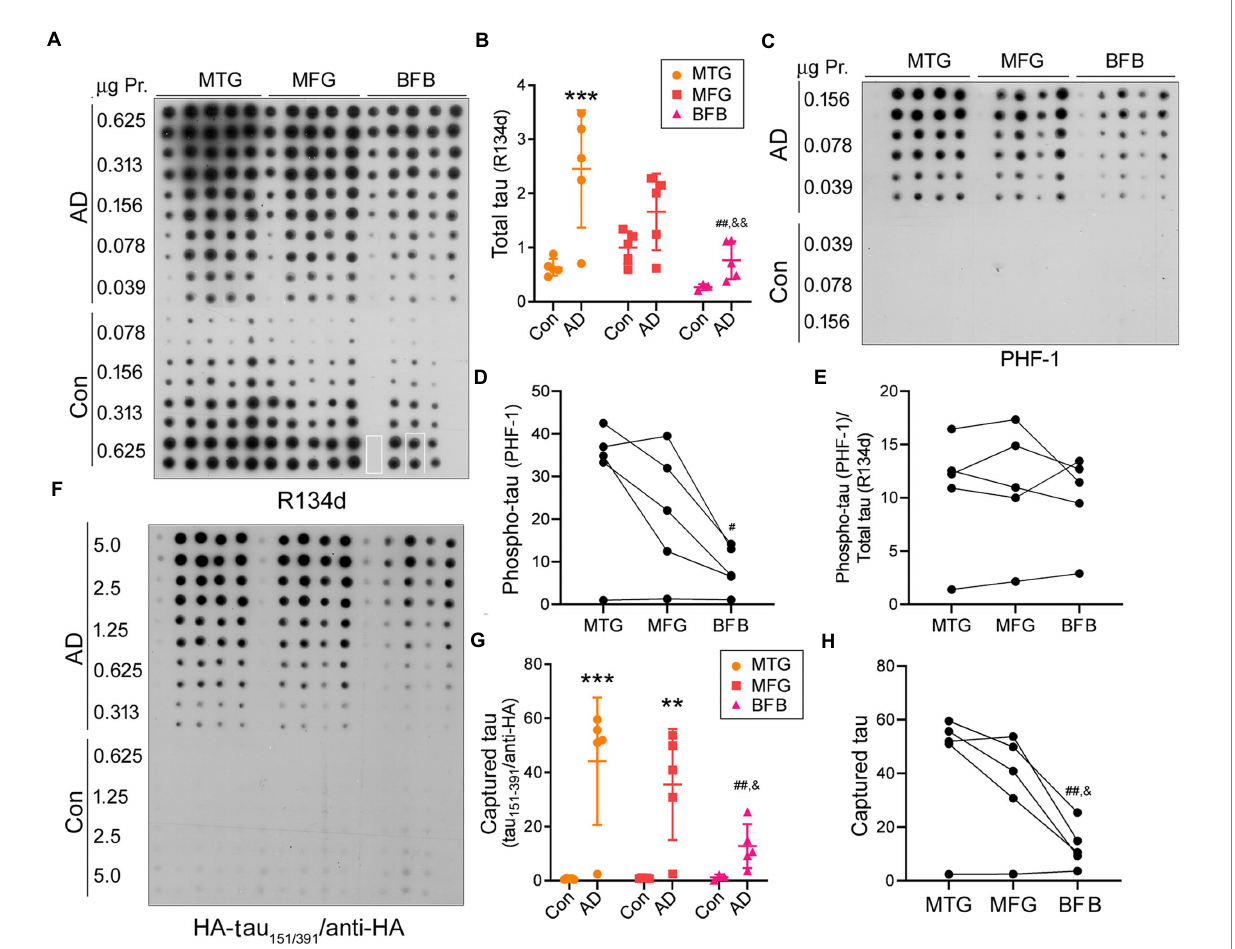
FIGURE 2 Tau seeding activity in AD brain assessed by the capture assay. (A,B) Increased tau level in MTG, MFG, and BFB of AD compared with the corresponding regions of control cases. Tau in brain extracts from three regions of AD and control cases was analyzed by immuno-dot blot developed with pan-tau antibody R134d (A) . BFB samples of control case 1 and case 5 were unavailable and therefore are not included here. The highlighted rectangles in R134d blot indicate the exchange of grids. Levels of tau are presented as scatter plots and mean ± SD (B) . (C–E) Hyperphosphorylated tau at PHF-1